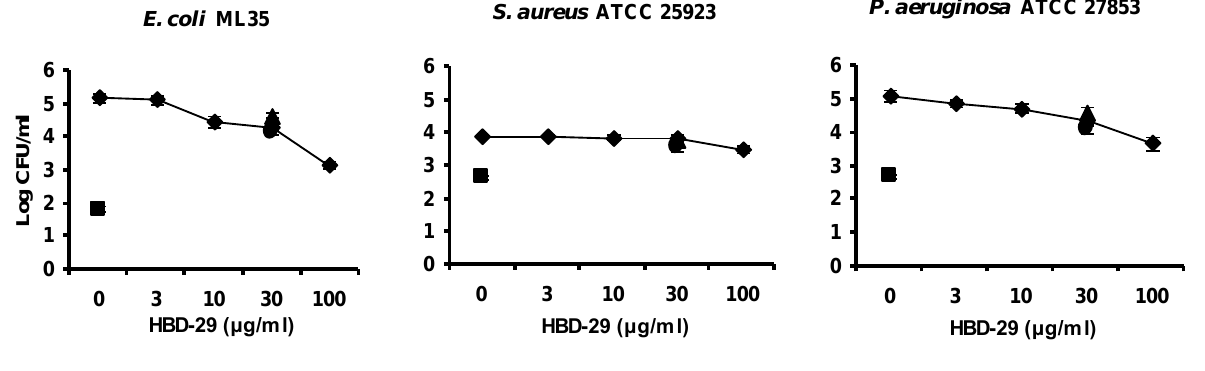
Figure 6. Antimicrobial activity of HBD-29 against three bacterial species. The antimicrobial activity of HBD-29 was evaluated by colony forming unit (CFU) assay and plotted on a logarithmic scale. The experiments were carried out using four different concentrations of HBD-29 (3 μg/mL, 10 μg/mL, 30 μg/mL, 100 μg/mL) with 20 mM lysozyme (square) as the positive bactericidal control. The bactericidal activity of 30 μg/mL HBD-29 was also tested in the presence of 150 mM NaCl (triangle) and 2 mM dithiothreitol (circle). The bacteria used were Escherichia coli ML35, Staphylococcus aureus ATCC 25923, and Pseudomonas aeruginosa ATCC 27853. The results shown are the average of five complete experiments with E. coli , four with S. aureus and five with P. aeruginosa; while some points on the graphs represent more experimental repetitions. Error bars show standard